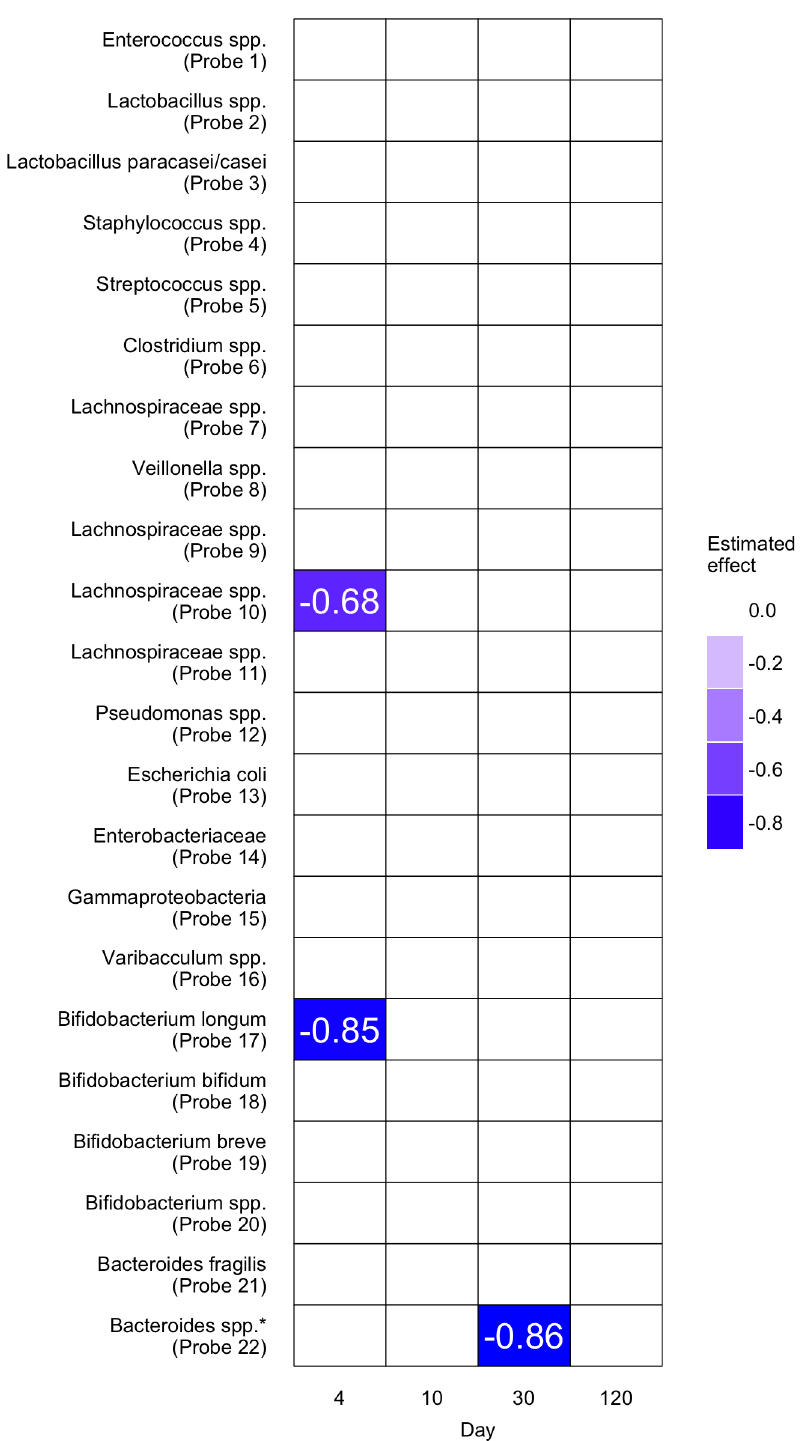
Figure 3. Results from the time-specific analyses for males. Coloured areas indicate significant results at 20% false discovery rate, and are labelled with their effect estimates, while white areas indicate non-significant results. Significant results at 5% false discovery rate are indicated by (cid:2) . Only the results for males are displayed, as no significant results were found for females. In certain situations, the outcome may be dependent on the By creating patterns consisting of two – or more – gut microbiota spp. interaction between two gut microbiota spp. groups, which would groups, and then applying the methods described here, the intra-gut microbiota spp. group dependencies can be accounted for. result in the above method not being appropriate without an extension.